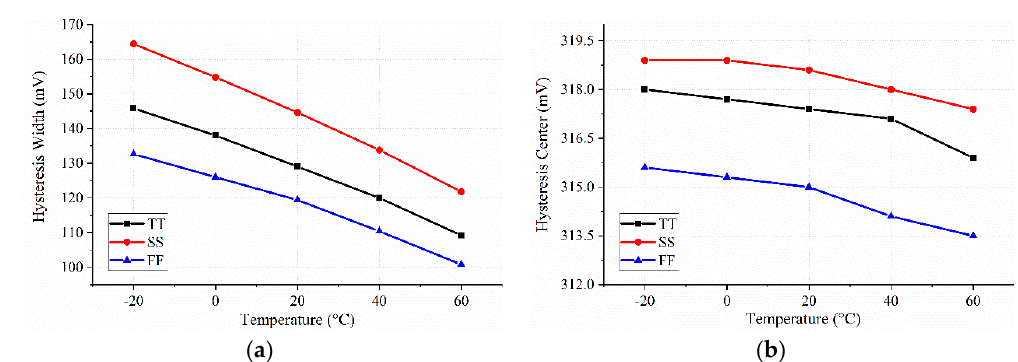
Figure 12. Variation of hysteresis ( a ) width and ( b ) center of the proposed Schmitt trigger from − 20 to 60 degrees Celsius in different process corners.